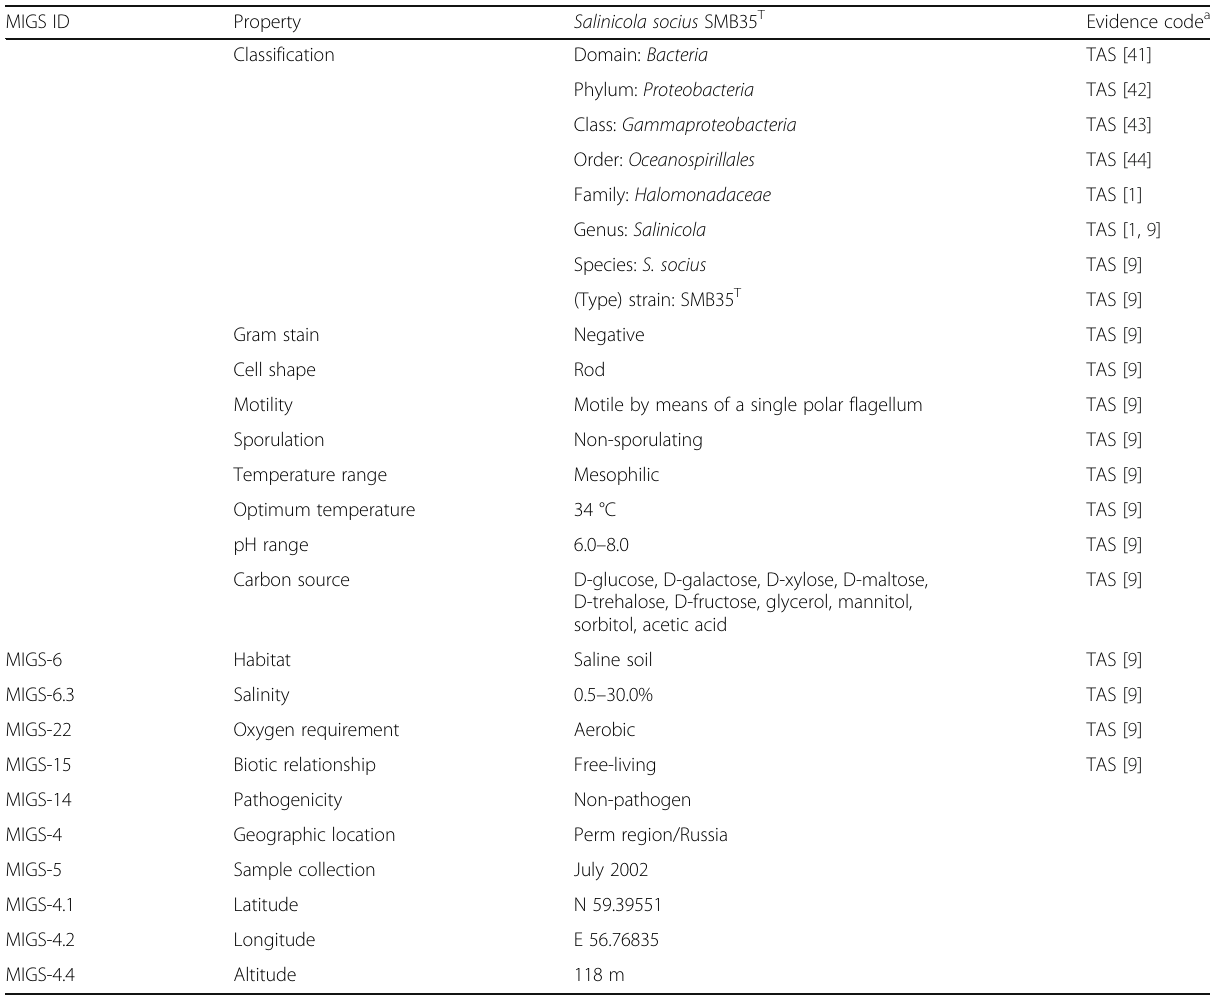
Table 1 Classification and general features of S. socius SMB35 T MIGS